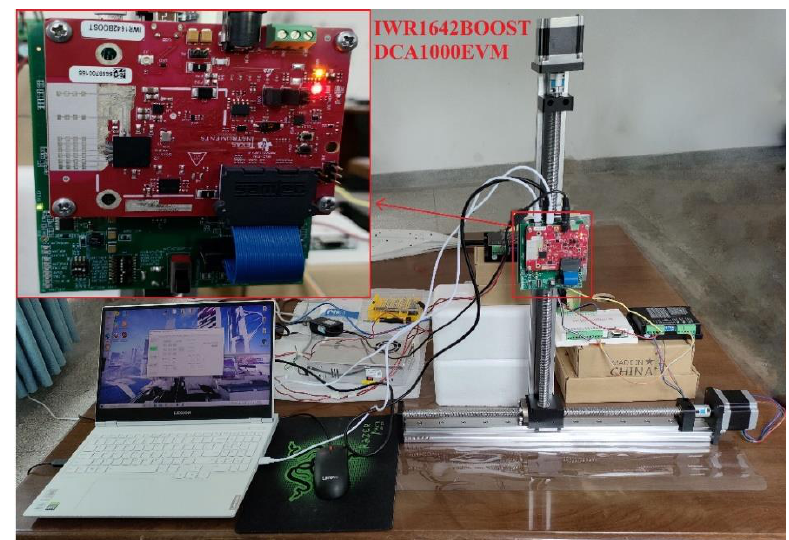
Figure 5. Experimental platform.